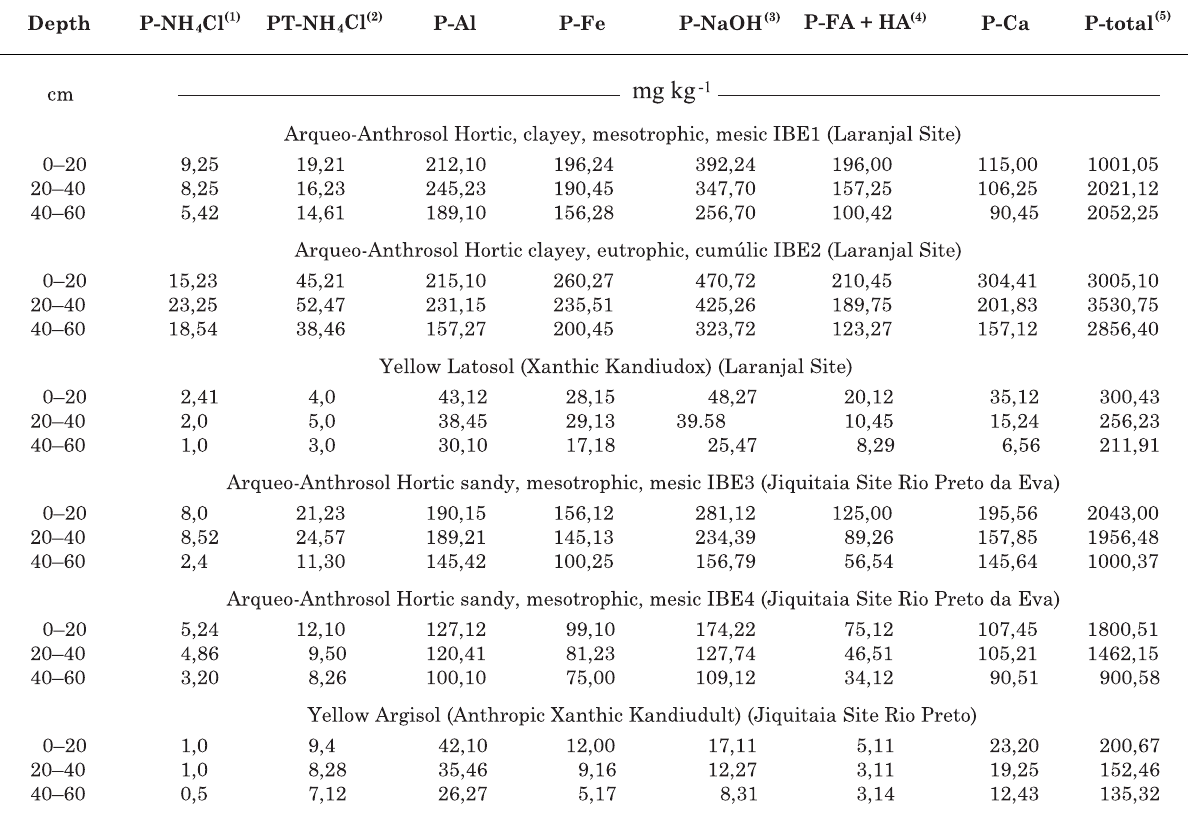
Table 3. Total and inorganic P forms